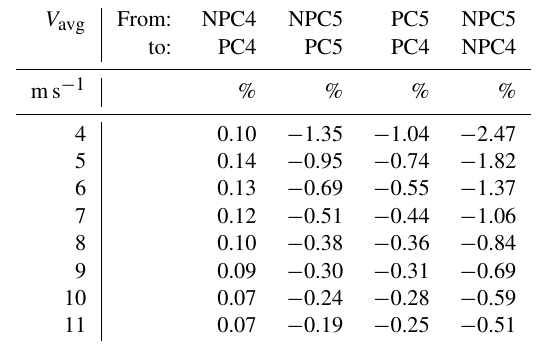
Table 2. Comparison between met-mast power curve (PC) and na- celle (spinner) power curve (NPC) in terms of annual energy pro- duction. The values in the table are calculated as (from/to − 1) · 100. The AEP was calculated with the extrapolated power curve from valid data to 25ms − 1 .